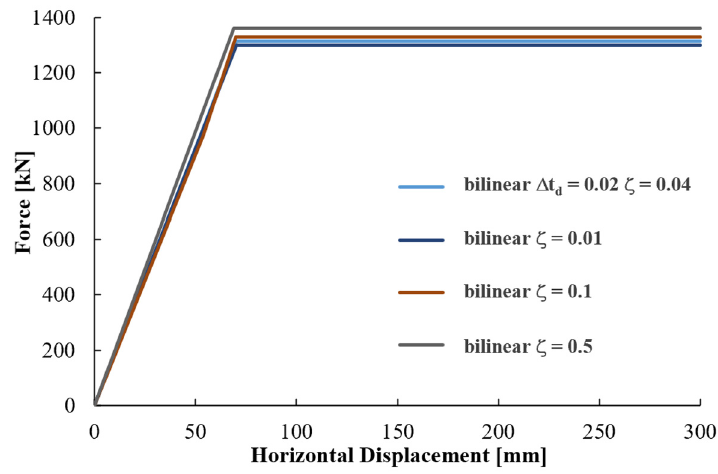
Figure A2. Pushover curve of 2D RC frame structure—damage level 1: effect of variation of damp- ing ratio.